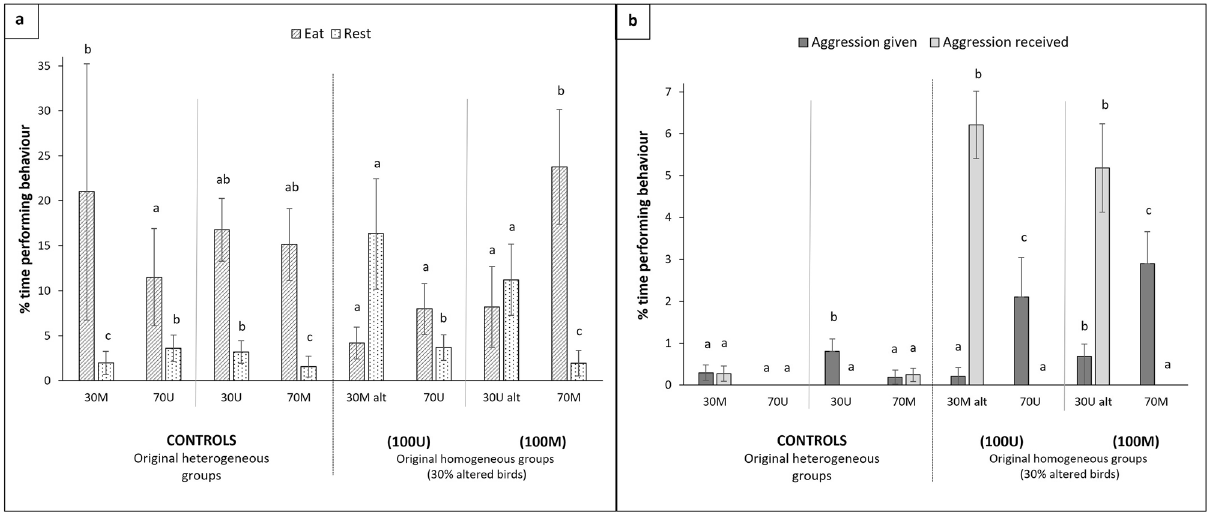
Figure 1. Effects of phenotype alteration to 30% of individuals on the behaviour of hens at 35–36 weeks of age (t1). M: marked; U: unmarked; alt: altered. Bars represent means ± standard errors. Different letters within the same behaviour indicate significant differences among groups at p < 0.05. ( a ) Effects on eating and resting behaviours. ( b ) Effects on aggression given and